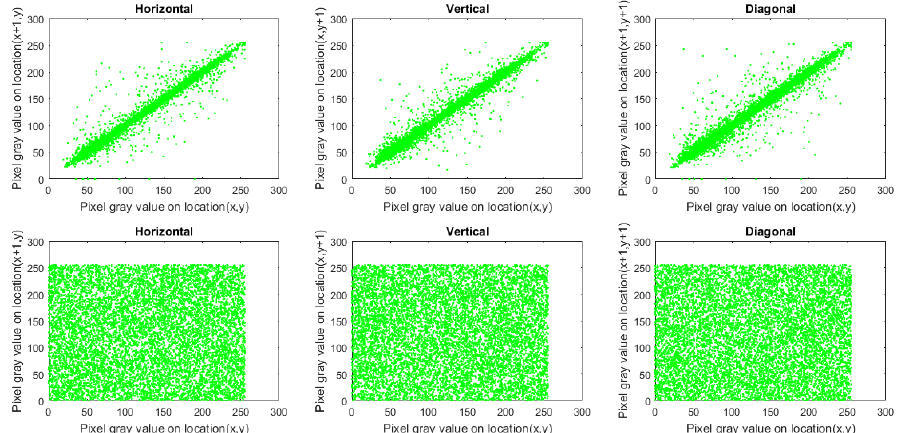
Figure 12. Plots of correlation distribution (in each direction) for Macaws image (Green channel), in which the first row denotes the plain Macaws image, while the bottom row signifies the ciphered Macaws